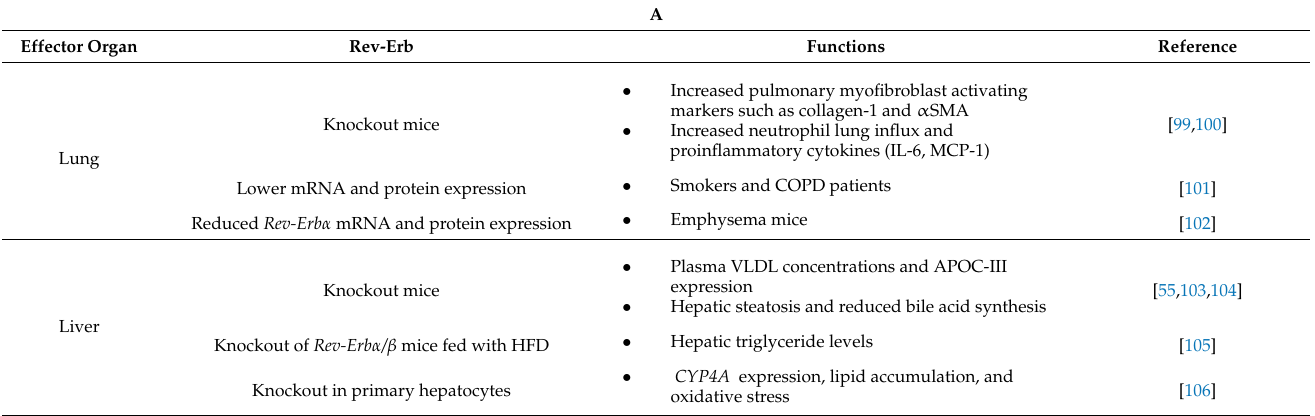
Table 1. Role of Rev-Erb and their synthetic ligands in tissue